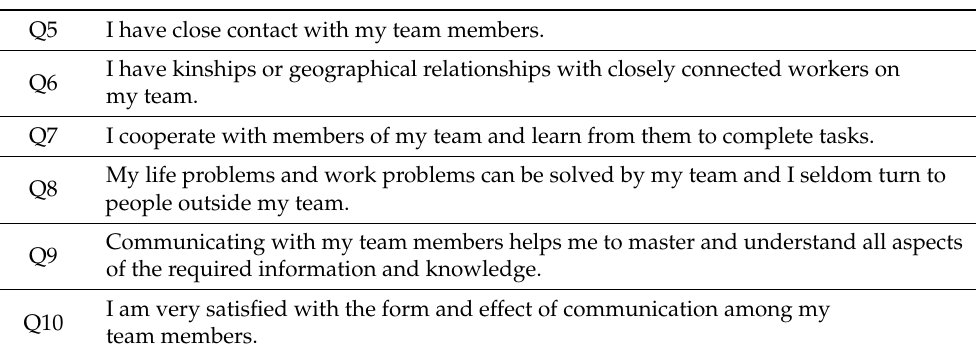
Table 2. Questions to verify the group characteristics of workers and their impact on knowledge transfer.